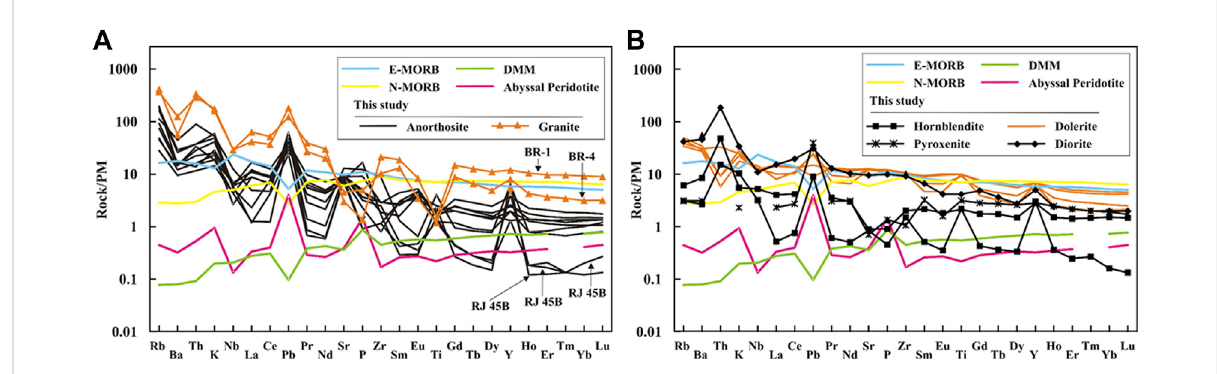
FIGURE 9 PMnormalizedwhole-rocktraceelementpatternsfor (A) anorthositeandgranitesamplesand (B) hornblendite,pyroxenite,dolerite,anddiorite samples from the Chotanagpur Granite Gneiss Complex (references as in Figure 7). Average enriched-MORB and normal-MORB from Sun and McDonough (1989), depleted MORB mantle from Workman and Hart (2005), and abyssal peridotite from Niu (2004). Normalizing values are taken from Sun and McDonough